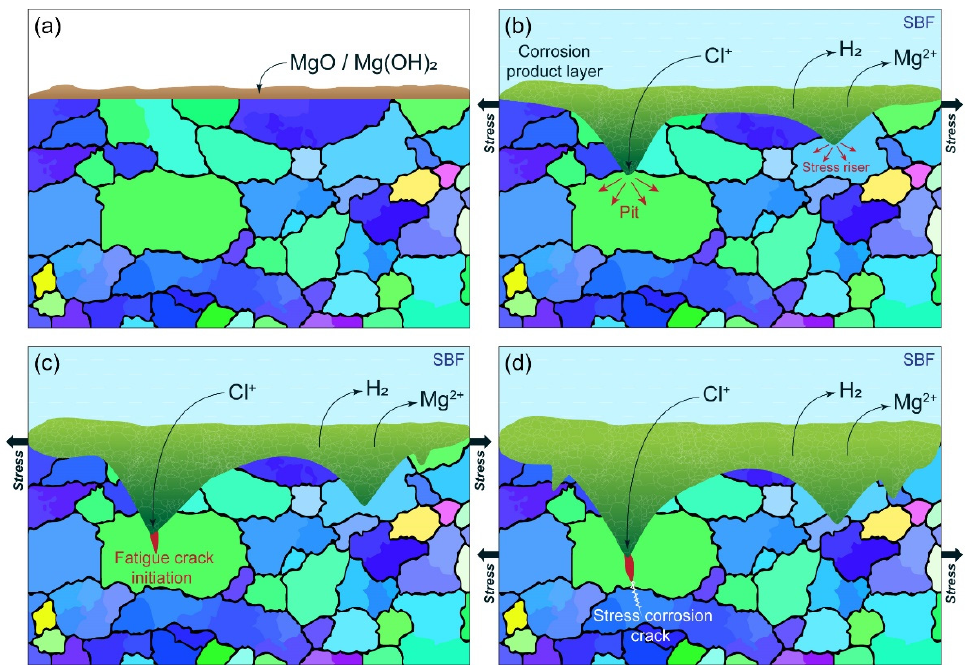
Figure 15. A simplified schematic illustration of the corrosion-fatigue-induced damage propagation. ( a ) Initial state with the MgO/Mg(OH) 2 protective film formed on the surface; ( b ) advanced stage of the stress-stimulated corrosion process with the protective film broken, resulting in the formation of corrosion pits and the corrosion product layer; ( c ) initiation of the fatigue crack at the stress concentrator created by the notch-like root of the corrosion pit; ( d ) stress corrosion cracking initiated in the vicinity of the sharp fatigue crack.